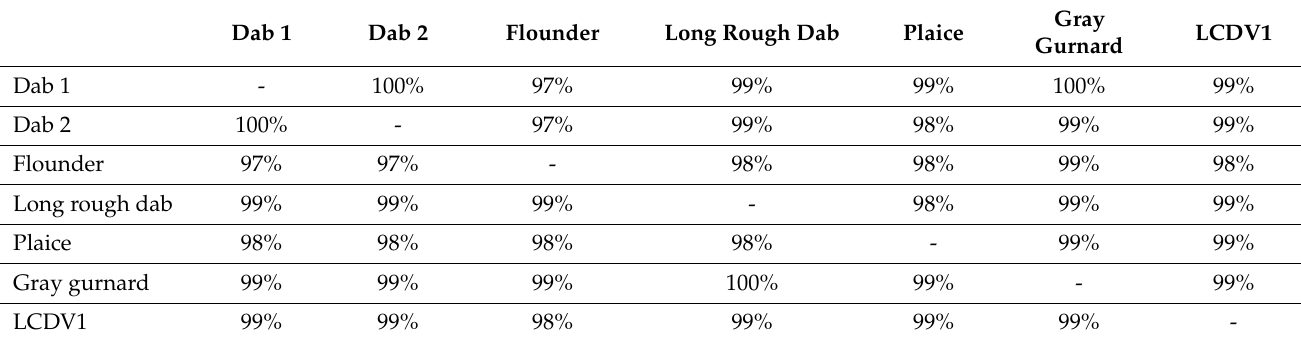
Table 2. Comparison of sequence similarities of partial MCP sequences (231–263 bp) obtained using nested PCR from different wild fish species caught in the North Sea between 1996 and 2003. LCDV1 (NC_001824).